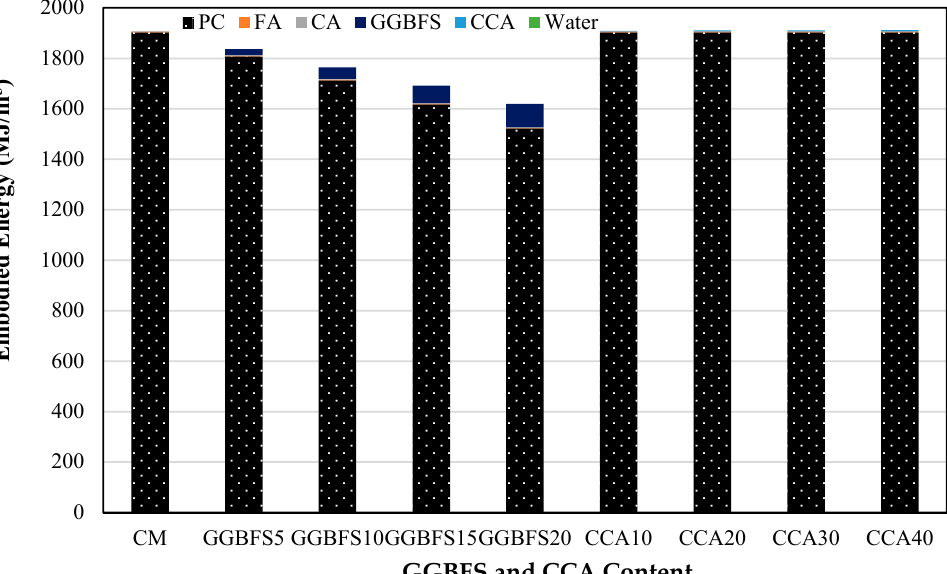
Figure 18. Embodied energy of concrete containing GGBFS and CCA.